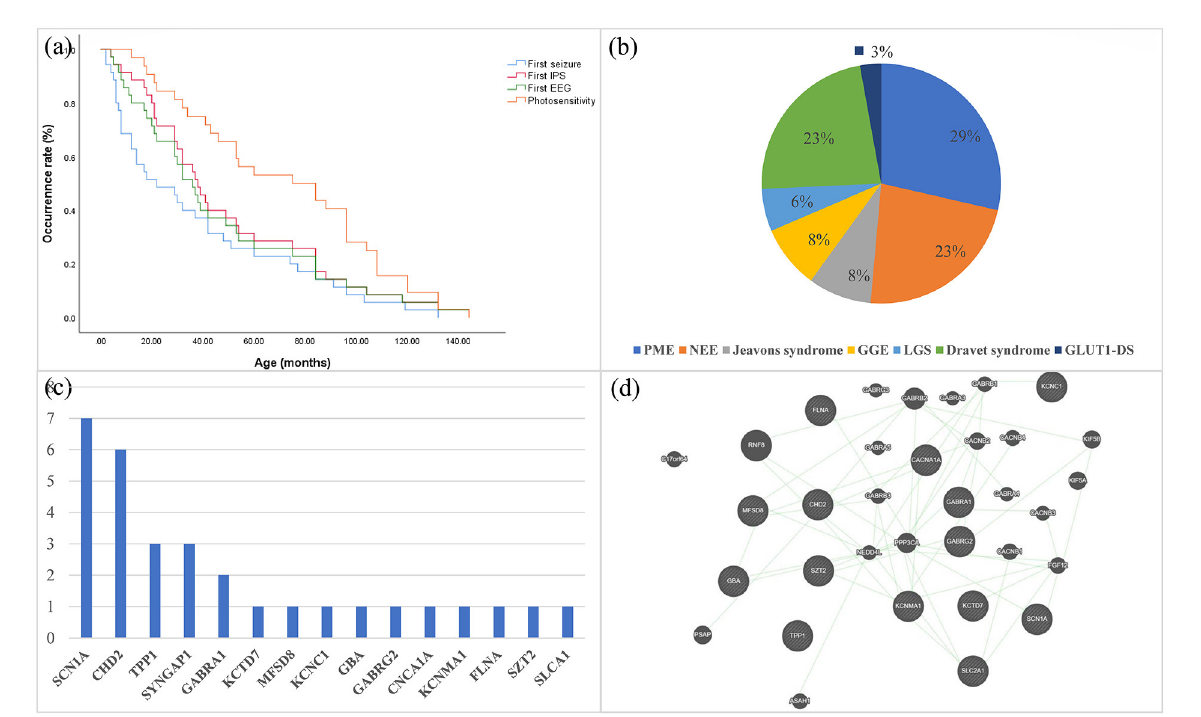
FIGURE1 (a) Kaplan–Meier estimates of the age of all patients at the time of first seizure, first EEG, first IPS, and first PPR/PCR are shown. (b) Distribution of syndromes in epileptic patients with genetic photosensitivity. (c) Frequency distribution of monogenic variants that are pathogenic or likely pathogenic for photosensitivity. (d) Prediction of the genetic interactions performed by Genemania (accessed on 11 March 2021). EEG, electroencephalography; IPS, Intermittent Photic Stimulation; PPR, photoparoxysmal response; PCR, photoconvulsive response; PME, progressive myoclonus epilepsy; NEE, unclassified epileptic encephalopathy; LGS, Lennox-Gastaut syndrome; GGE, genetic generalized